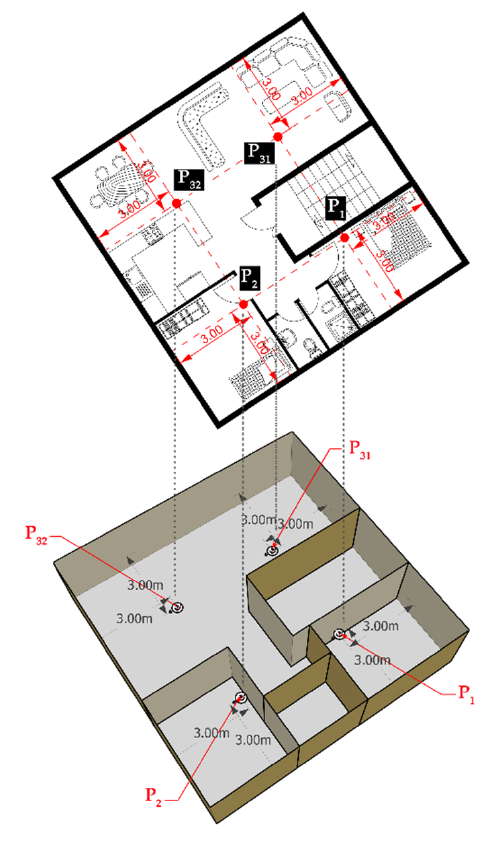
Figure 6. Placement of the control points.